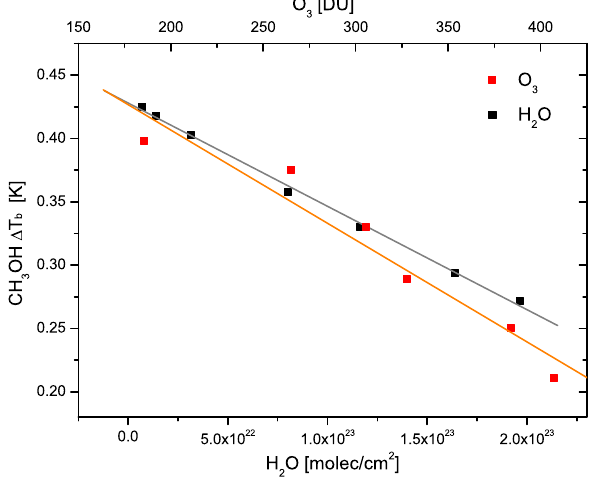
Fig. 4. Illustration of the influence of water vapor and ozone con- centrations on the methanol 1T b . Simulations were performed for the midlatitude summer model with varying concentrations of H 2 O (black squares) and O 3 (red squares) while the CH 3 OH amount was fixed. In both cases, a linear dependence is